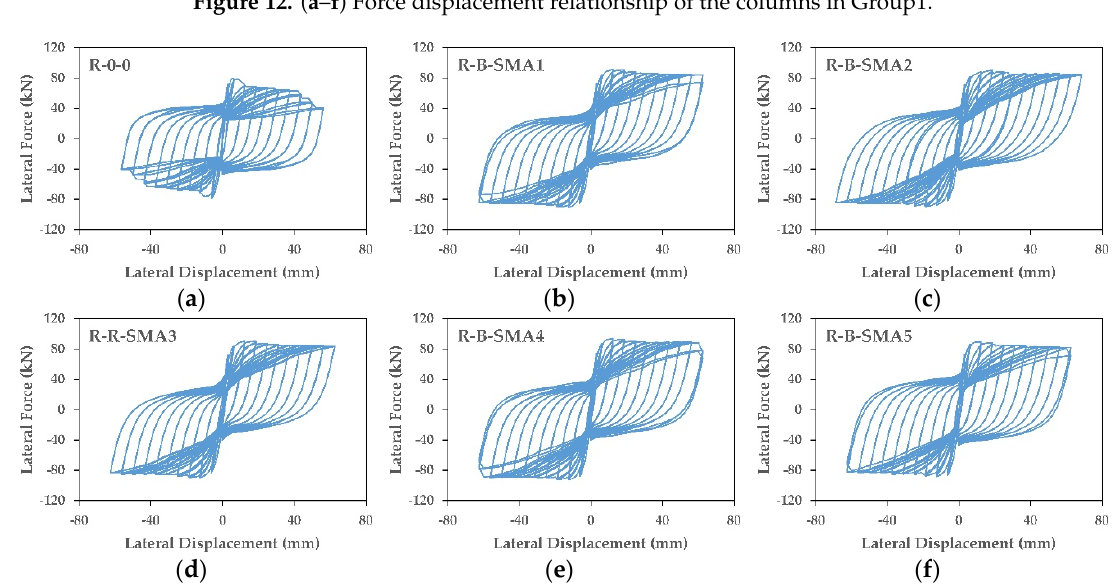
Figure 13. ( a – f ) Force displacement relationship of the columns in Group2.